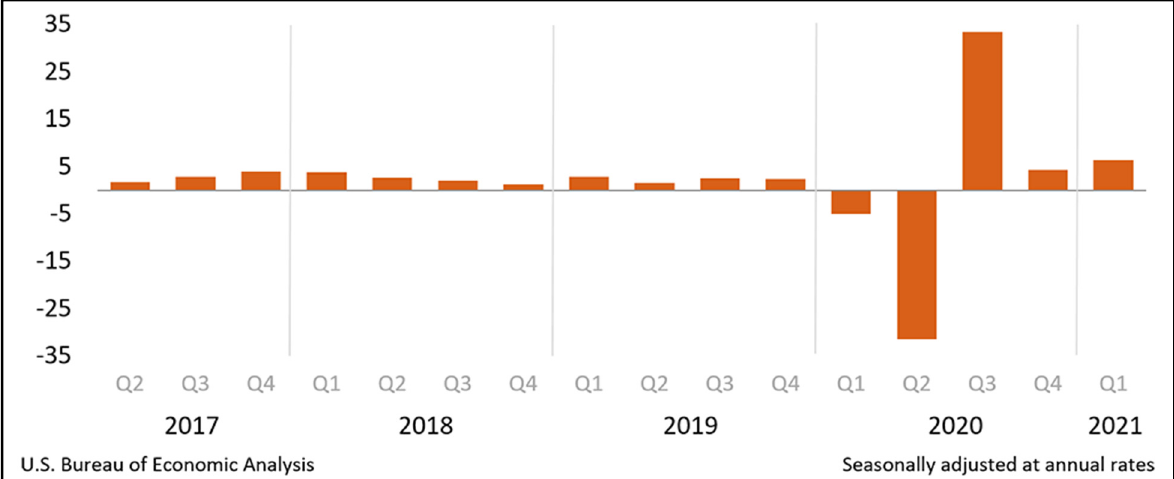
Figure 1. Real Gross Domestic Product (GDP): Percent change from preceding quarter. (Source: Reproduced from The United States (U.S.)Bureau of Economic Analysis) [17].